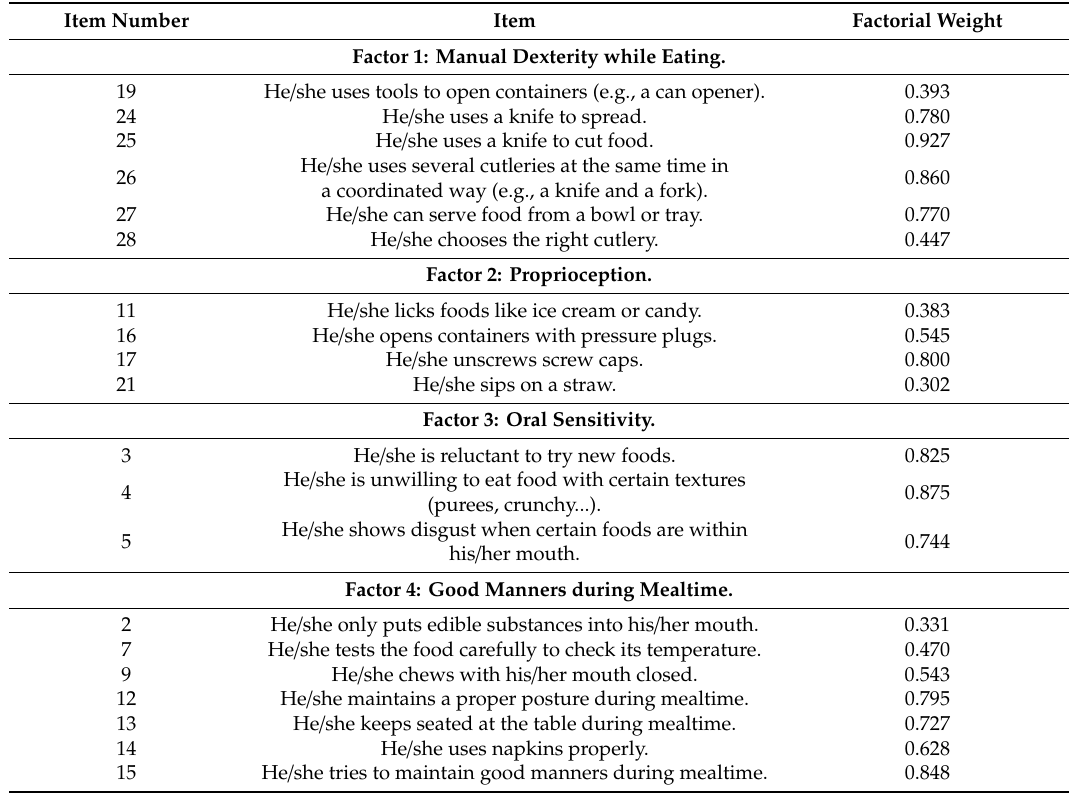
Table 5. Eating scale factorial